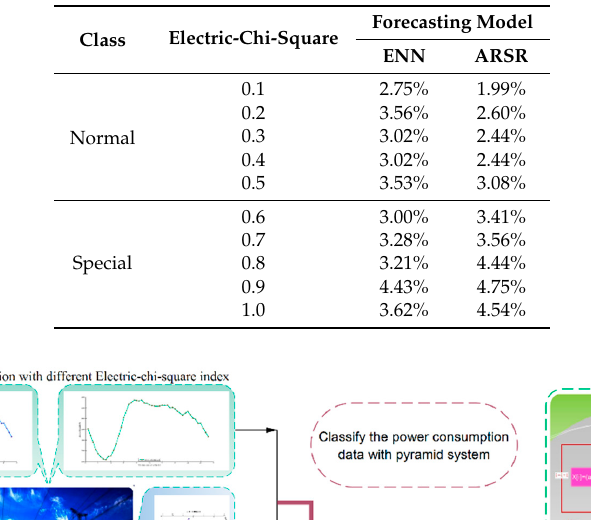
Table 4. Forecasting error results (MAPE).